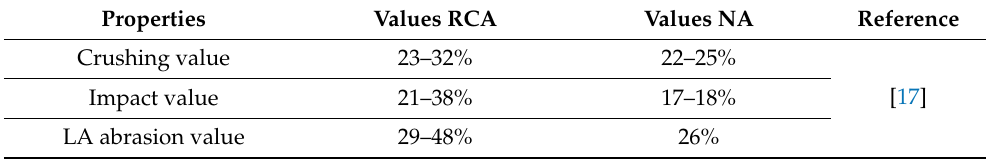
Table 2. Comparison of mechanical properties between RCA and